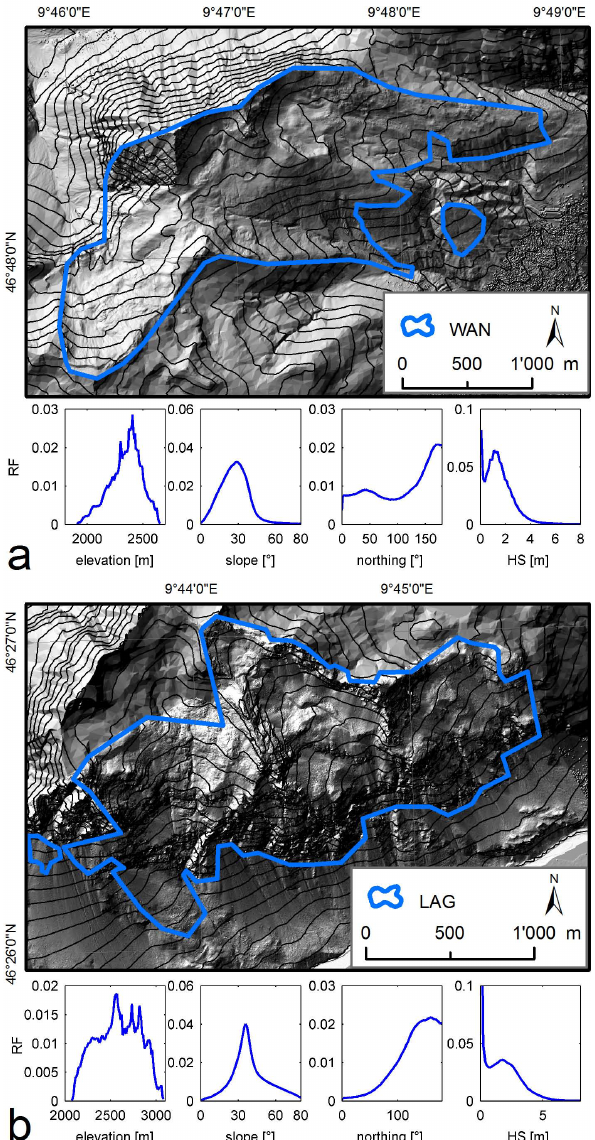
Fig. 1. Hillshade map of (a) the Wannengrat (WAN) and (b) the Piz Lagrev (LAG) study areas. The contour lines have an equidis- tance of 50m. The right panels show histograms for elevation, slope, northing and the area-wide absolute snow depth obtained from ALS. Data source basemap: (a, b) DOM-AV© 2012 swisstopo (5704000000).